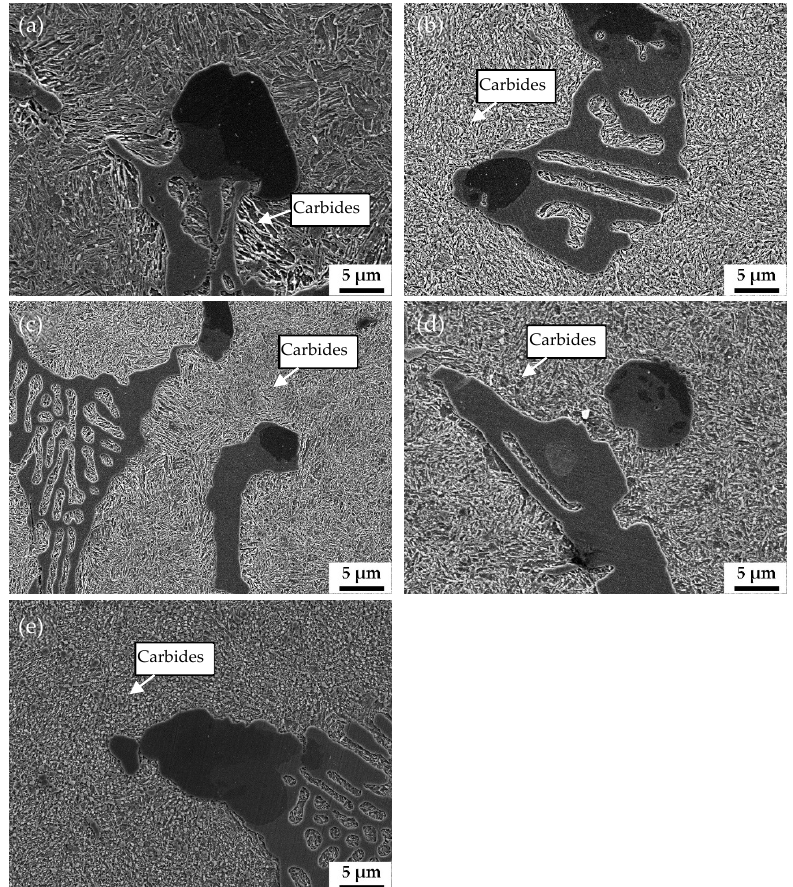
Figure 6. SEM images of V3 tempered at different temperatures: ( a ) 150 °C, ( b ) 250 °C, ( c ) 350 °C,